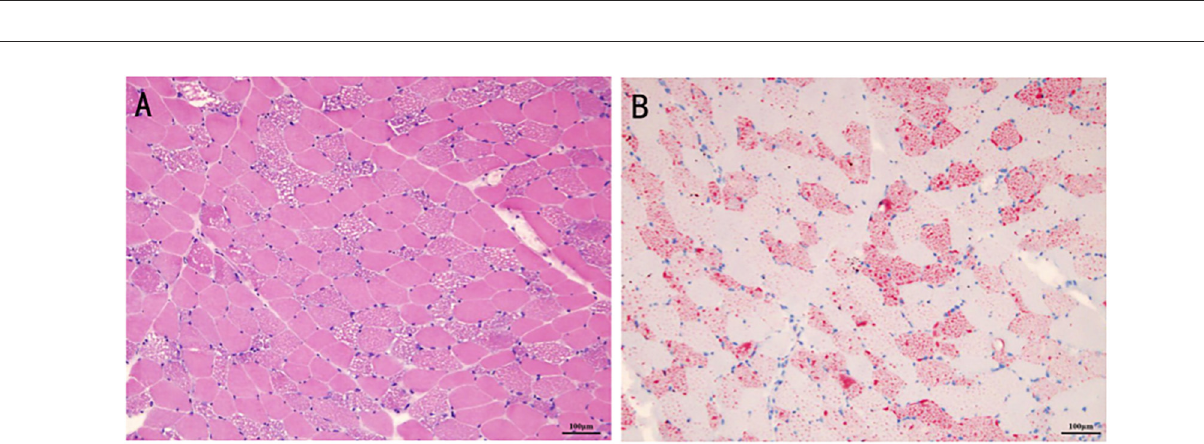
conserved among species (Figure 4A). This mutation was graded as variant uncertain significance (VUS) according to ACMG.